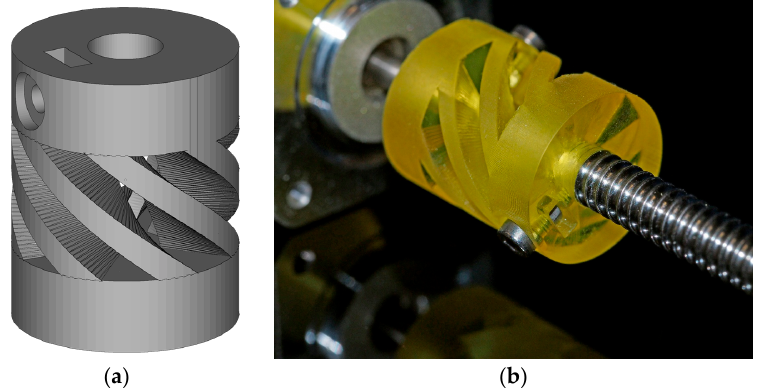
Figure 7. CAD model of a functional shaft coupling ( a ), and the final assembled 3D-printed part ( b ). Printed with 1.18 wt % TPO-L.